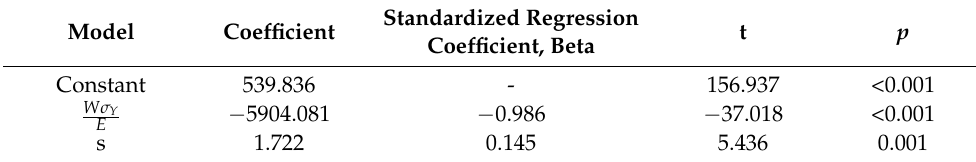
Table 11. Coefficients of the regression model for multi-asperity test.